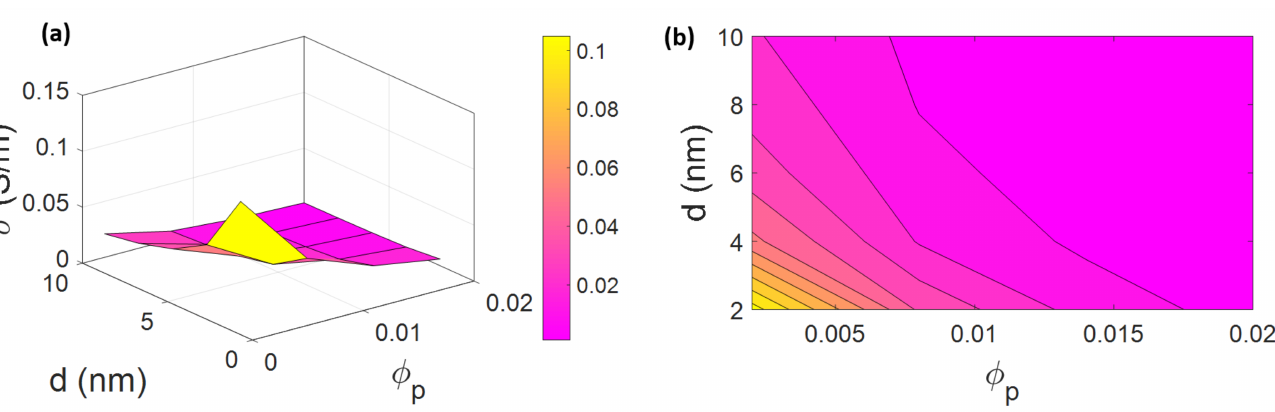
Figure 5. Theoretical conductivity by “ ϕ p “ and “ d “: ( a ) 3D and ( b ) contour